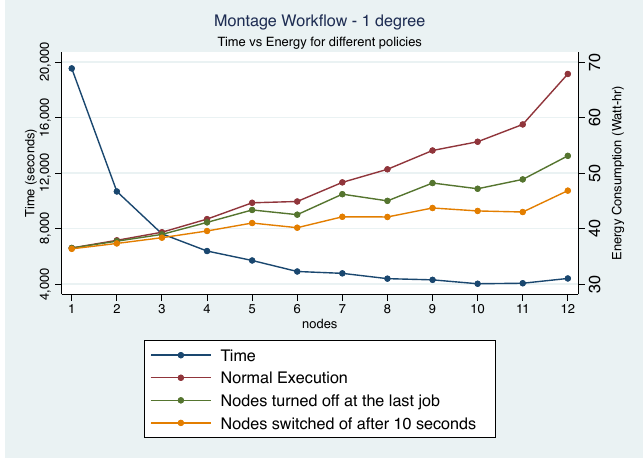
Figure 19. Time vs. Energy for Montage workflow as per different policies.